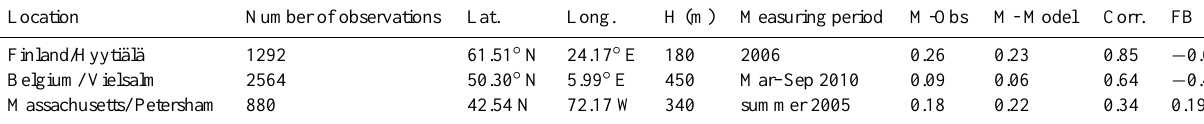
Table 1. Comparison of the mean (M) monoterpenes mixing ratios (ppbV) between observed and calculated data by DEHM, using the MEGAN biogenic model, for the time periods corresponding to the measuring period at the individual sites. The evaluations for the sites in the US and in Europe are performed using statics parameters of the correlation coefficient (Corr.) and the fractional bias (FB). H is the height of the station above sea-level.